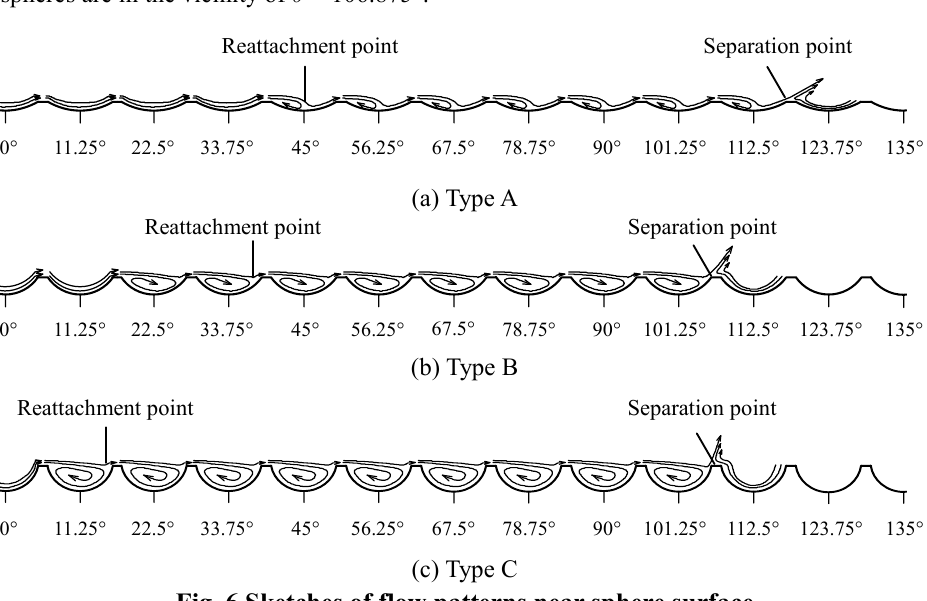
Fig. 6 Sketches of flow patterns near sphere